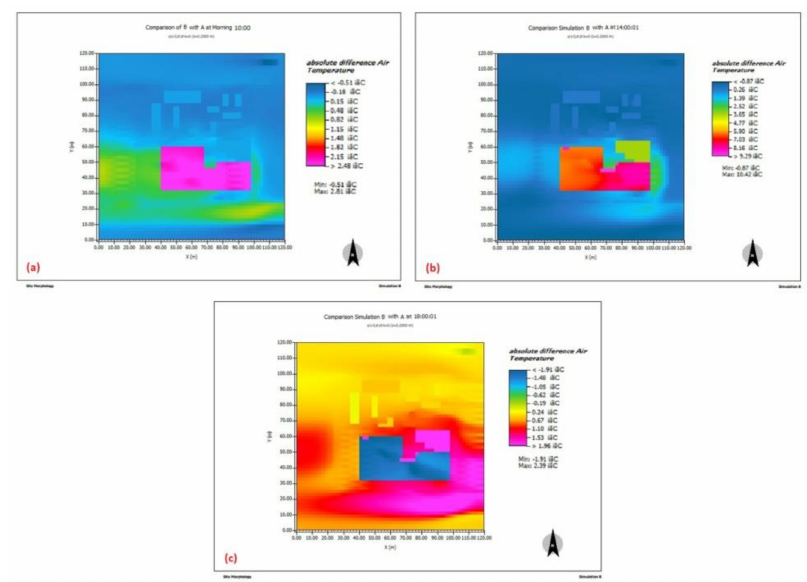
Figure 12. Comparison of T air differences in the( a ) morning; ( b ) afternoon; and ( c ) evening.